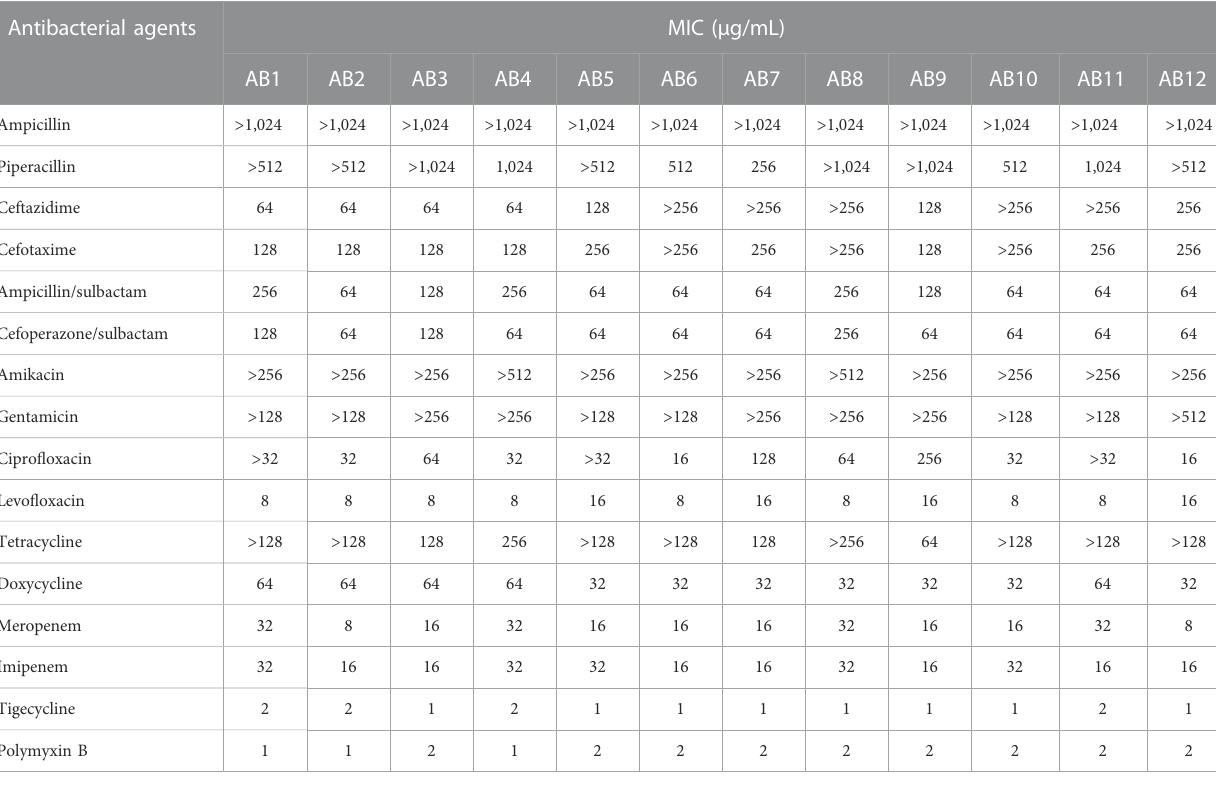
TABLE 3 MICs of 16 antibacterial agents against 12 clinical isolates of A. baumannii . Antibacterial agents